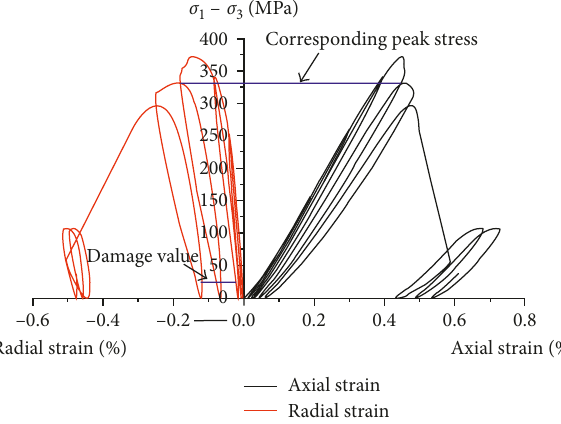
Figure 1: Diagram of damage value